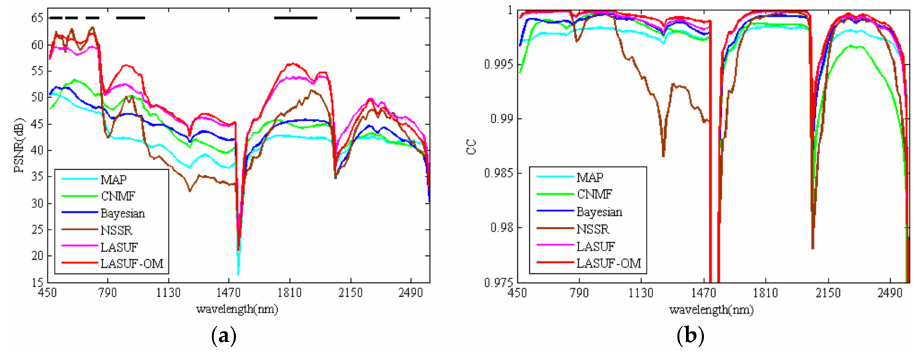
Figure 9. Comparisons of statistical indexes of individual bands for Montana: ( a ) PSNR; ( b ) CC.